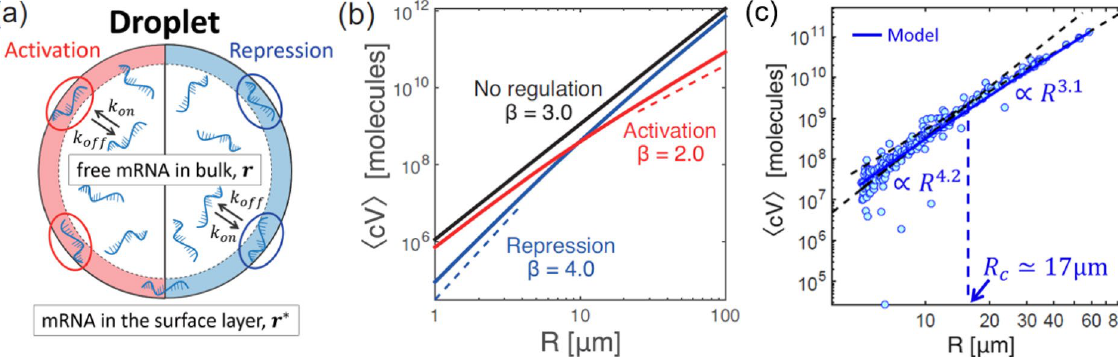
Figure 4. ( a ) Schematic illustration of the surface regulation model in a cell-sized compartment. ( b ) Theoretical analysis of anomalous scaling of produced protein 〈 cV 〉 in confined cell-free systems. Three types of regulation regime show different size-dependent scaling. Repression (blue, α α  ⁎ ), no regulation (black, k on = 0), and activation (red, α α  ⁎ ) correspond to β = 4.0, β = 3.0, and β = 2.0 for 〈 cV 〉 ∝ R β respectively (broken lines are guide for the eyes). ( c ) Total produced protein number 〈 cV 〉 is plotted along radius of droplet R . The data shown are the same as CFGE in Fig. 3(b) (blue circles), and Eq. (6) is fitted to them with a least-square regression (blue solid curve). Black broken lines are fitted to the data points R < R c and R > R c , and the corresponding slopes are shown as the texts R 4.2 and R 3.1